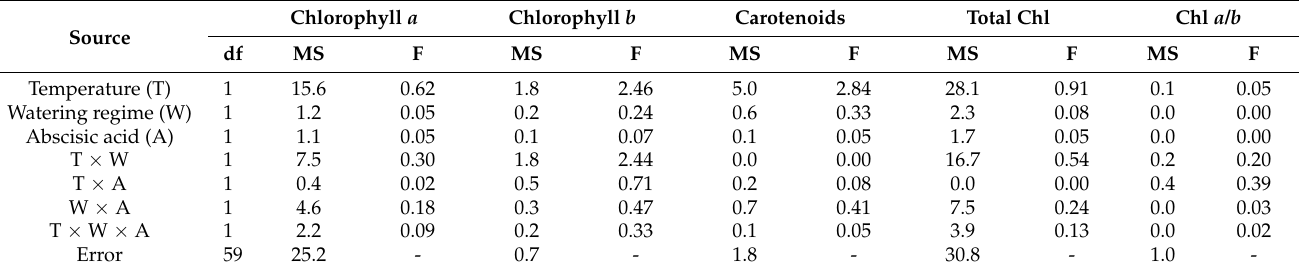
Table 13. Analysis of variance for effects of temperature, watering regime, abscisic acid, and their interactions on photosynthetic pigments of tomato